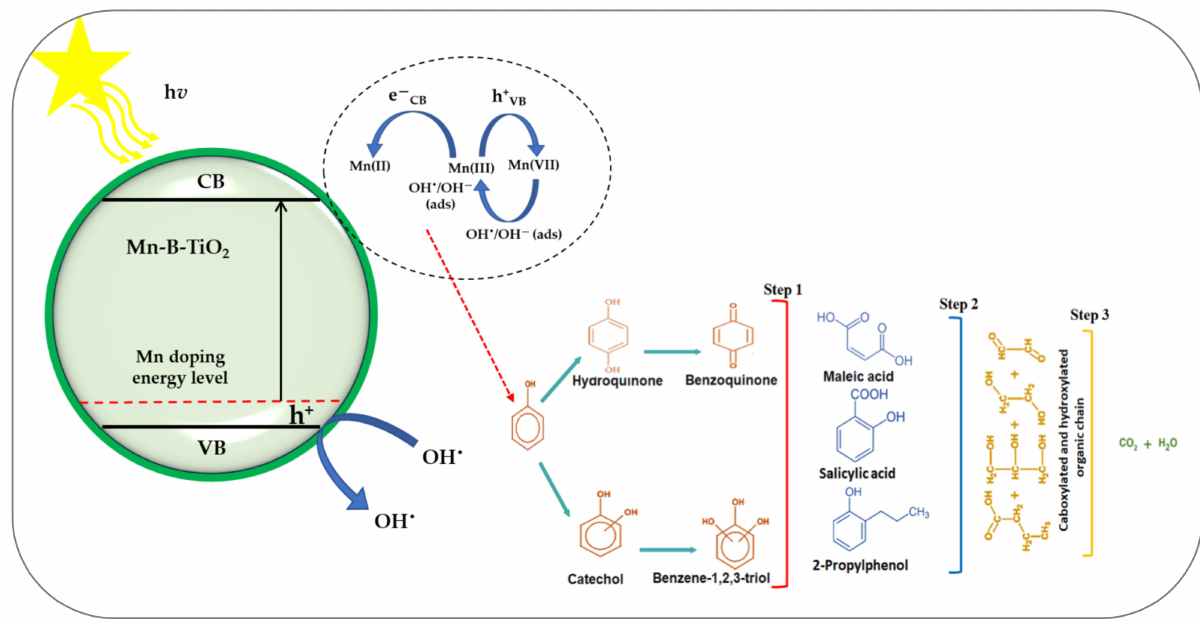
Figure 8. The photocatalytic degradation mechanism of phenols over Mn-B-TiO 2 under visible light irradiation